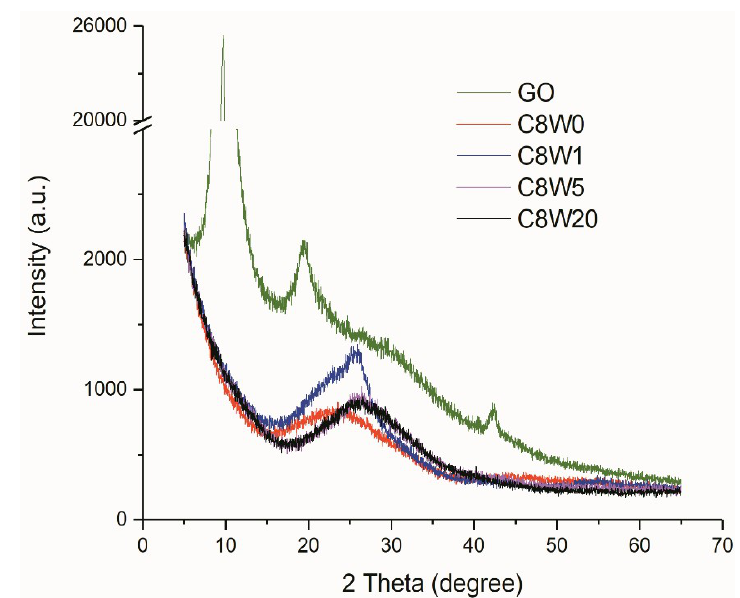
Table 3. Lc and La of AGAs with different microwave treatment durations.